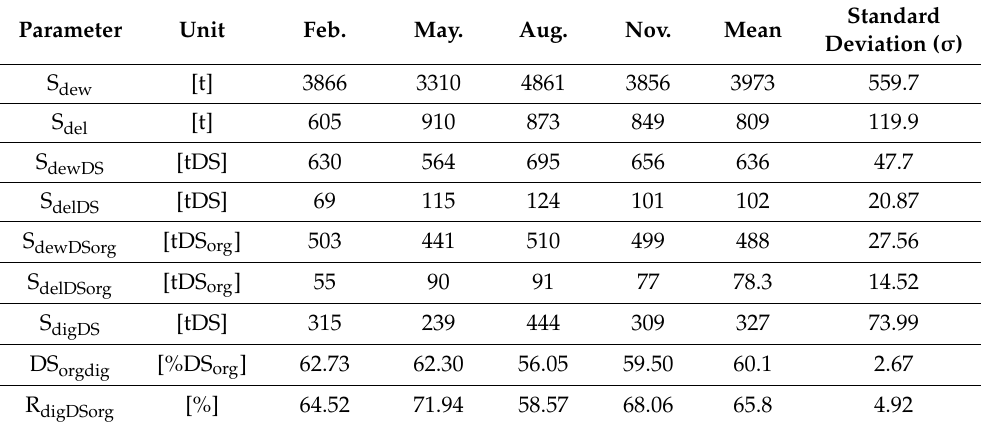
Table 1. Basic sewage sludge (SS) data calculated from Sections 2.1–2.5—amount of dewatered sludge (S dew ), delivered sludge (S del ), dry matter of dewatered sludge (S dewDS ), delivered sludge (S delDS ), sludge after THP and AD (S digDS ), organic dry matter of dewatered sludge (S dewDSorg ), delivered sludge (S delDSorg ), percentage of organic dry matter of sludge after THP and AD (DS orgdig ) and total reduction of dry organic matter in the process (R digDSorg ).